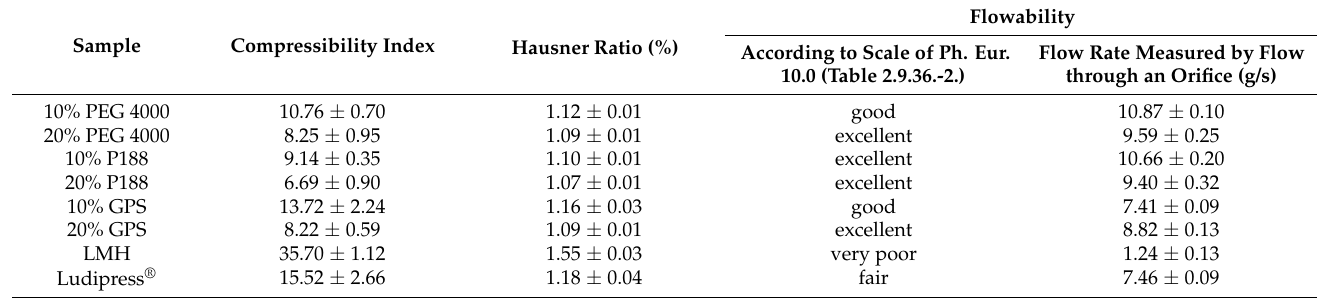
Table 2. Flowability of co-processed mixtures, LMH and Ludipress ®